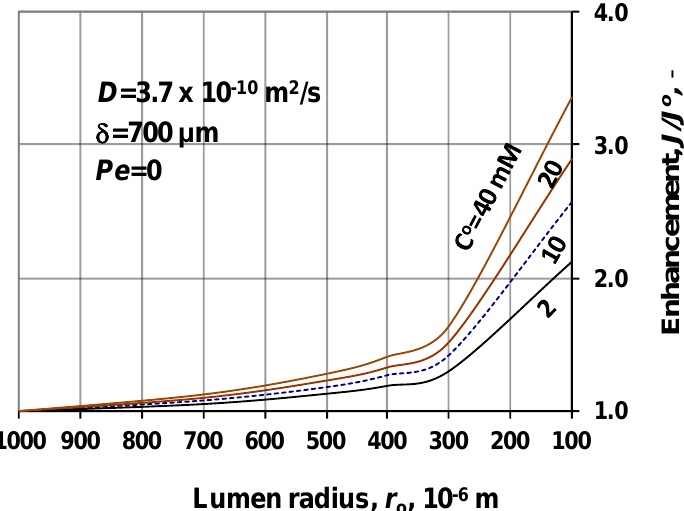
Figure 9. Enhancement as a function of the membrane radius, at different values of the inlet substrate concentration ( D = 3.7 × 10 − 10 m 2 / s; δ = 700 µ m; Pe o = 0; N = 1000).